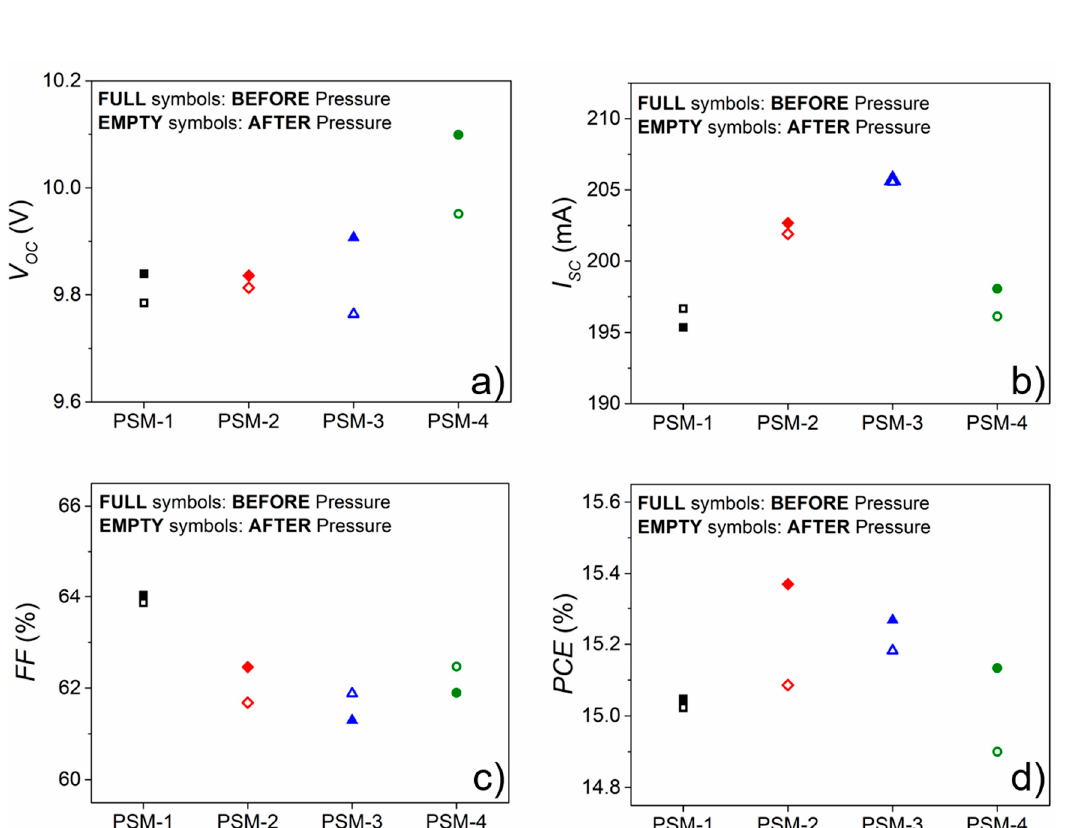
Figure 9. Electrical parameters related to 4 modules, realized by employing the optimized P3 process and extracted by the I-V curve acquired before (full symbols) and after (empty symbols) the applied pressure, miming the pressure experienced during a standard lamination process.( a ) open-circuit voltage V OC ; ( b ) short-circuit current density J SC ; ( c ) fill factor FF and ( d ) power conversion efficiency